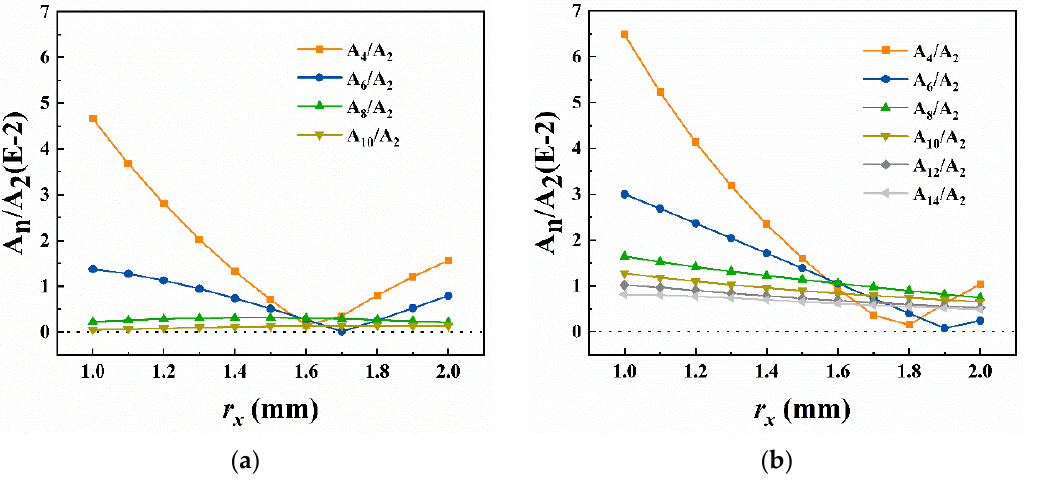
Figure 4. Variation of the high-order fields with r x at Δ r y = 0.75 mm. ( a ) 2-slit model; ( b ) 4-slit model. More slits on electrodes introduced higher-order fields and increased the overall contents and higher rate of changes.